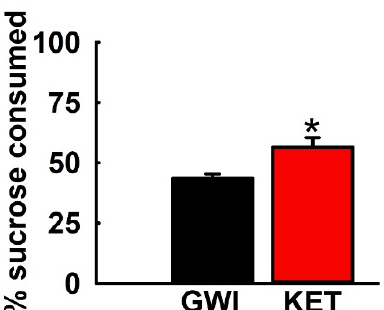
Figure 6. Effect of KET on the SPT in a DFP rat model for GWI . GWI rats treated with KET (10